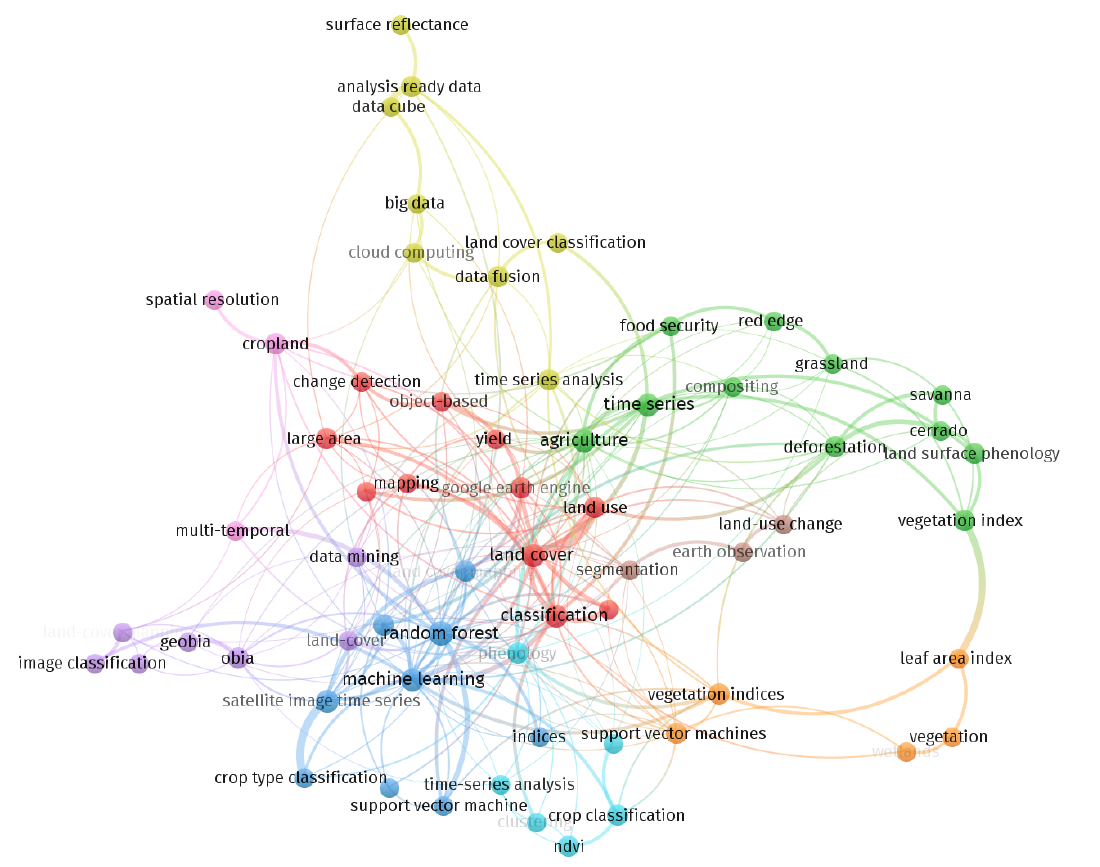
Figure 4. Scientific network mapping of the most used keywords terms in the selected papers. Colors indicate the cluster in which each keyword was related the most. Lines represent co-occurrence link strength among